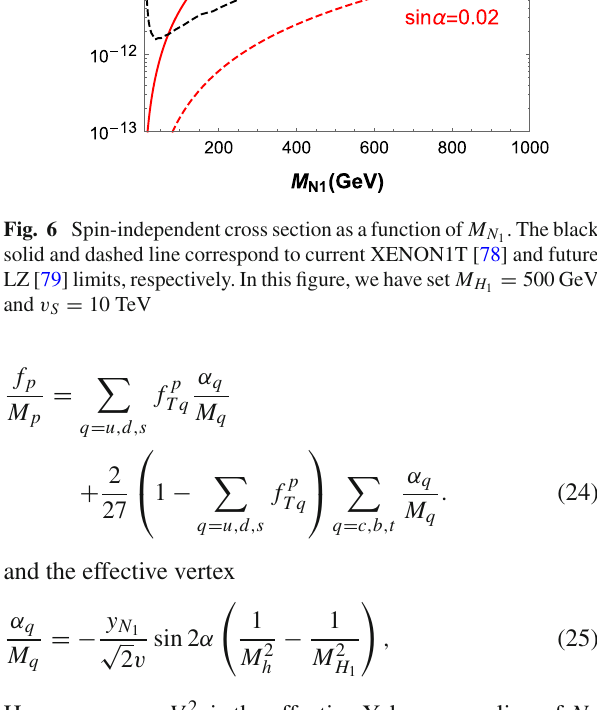
- M η plane. The green lines satisfy 1